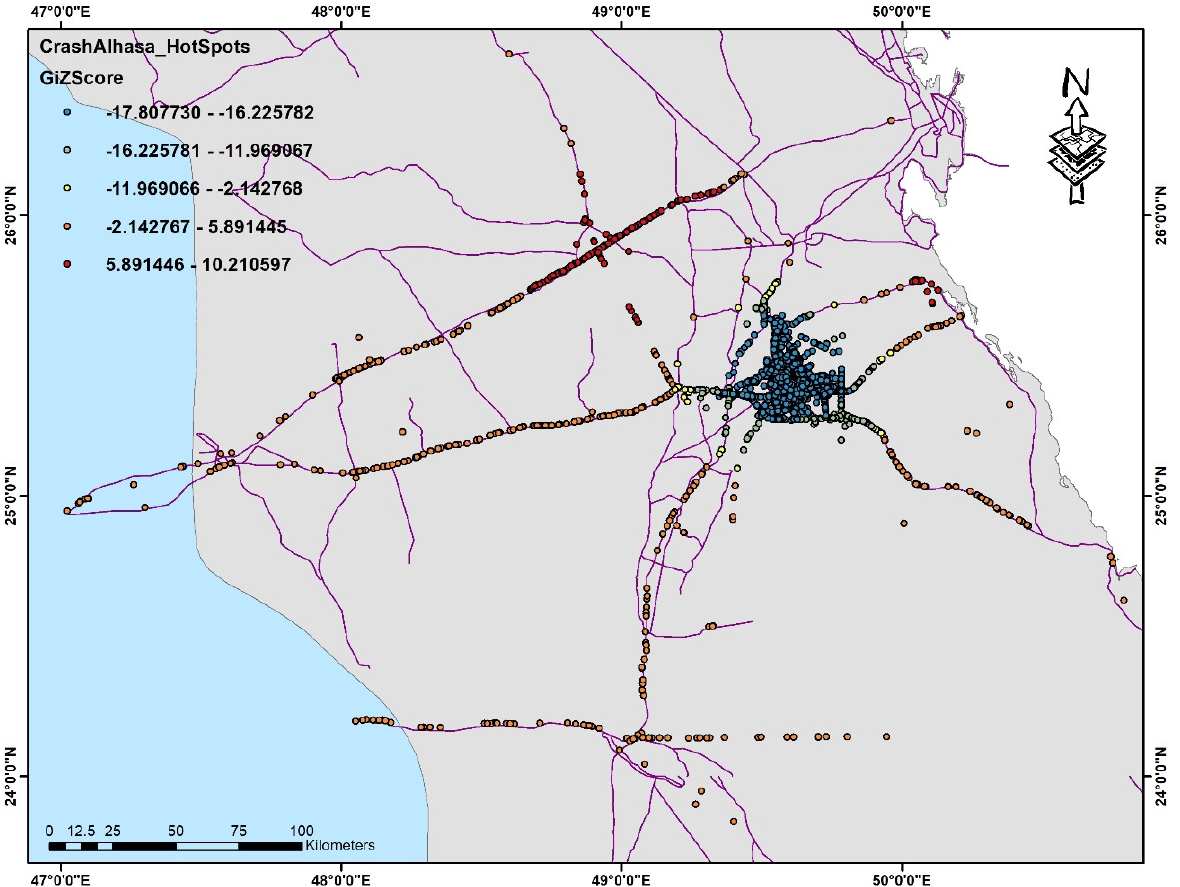
Figure 9. Composite spatial geographic distribution map of traffic crash hotspots based on the G ∗ score at the year level from 2016 to 2018.